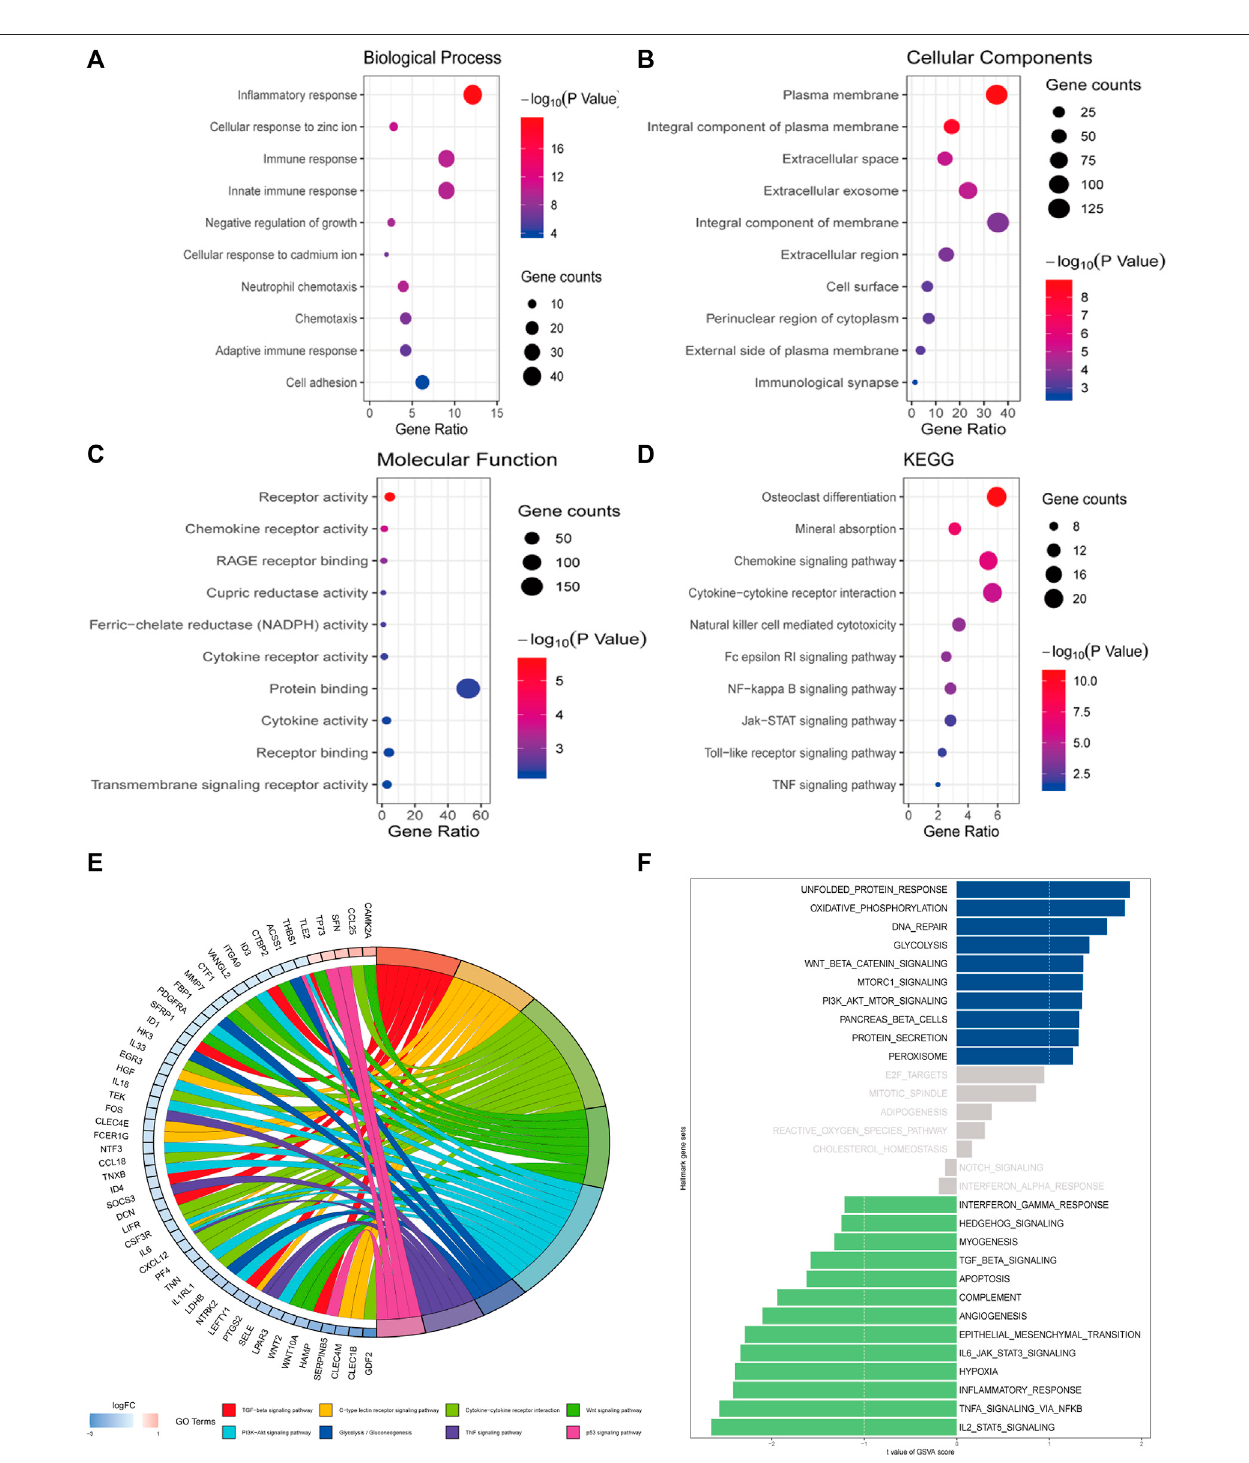
FIGURE7| Functionalandpathwayenrichmentanalysesof MT1H anditsco-expressedgenes. (A – D) Bubbleplotsrepresentingenrichedfunctionsandpathways of genes co-expressed with MT1H. (E) Analysis on the KEGG gene set between samples with high or low MT1H expression. (F) ssGSVA on the hallmark gene set between samples with high or low MT1H